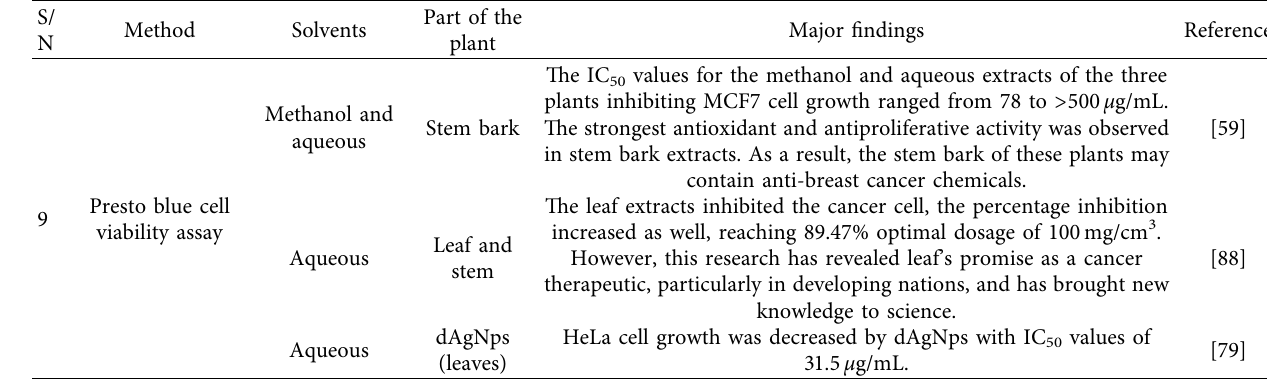
Table 9: Anticancer activity of D. microcarpum